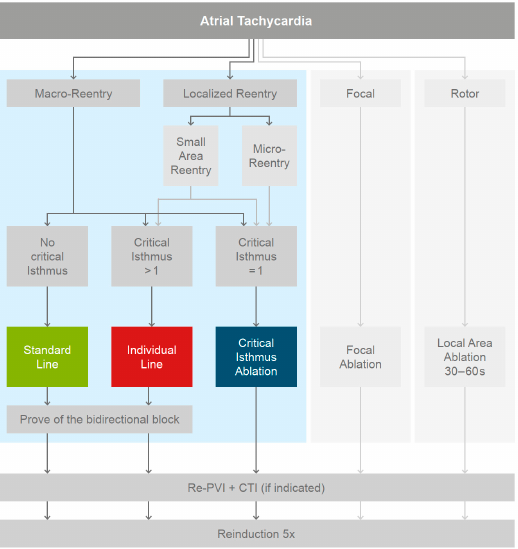
Figure 2. PVI = pulmonary vein isolation; CTI = cavotricuspid isthmus. Macro-reentry = circular activation around an anatomical obstacle. Localized reentry = circular reentry not involving an anatomical structure but around a spot presenting double potential (micro-reentry) or around an area or line of block (small-area reentry). Focal = true focal automatisms not related to structurally altered tissue, with a centrifugal excitation covering only part of the cycle length. Rotor = spiral excitation wavefronts.